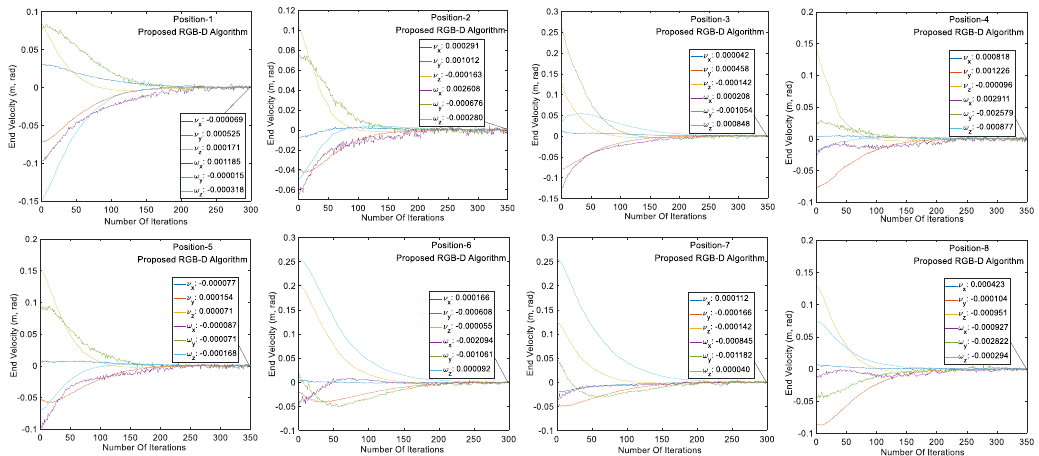
Figure 13. Manipulator speed change of proposed RGB-D image processing algorithm.